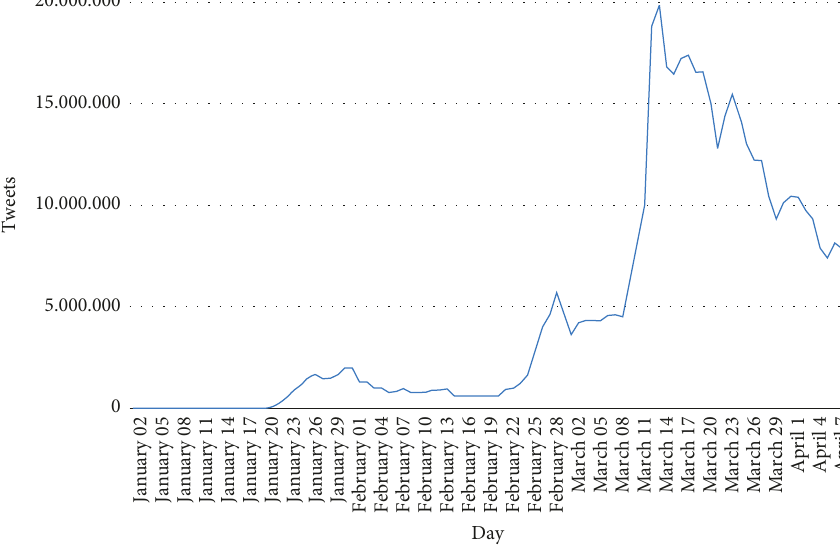
Figure 1: Tweets about COVID-19 during the last 4